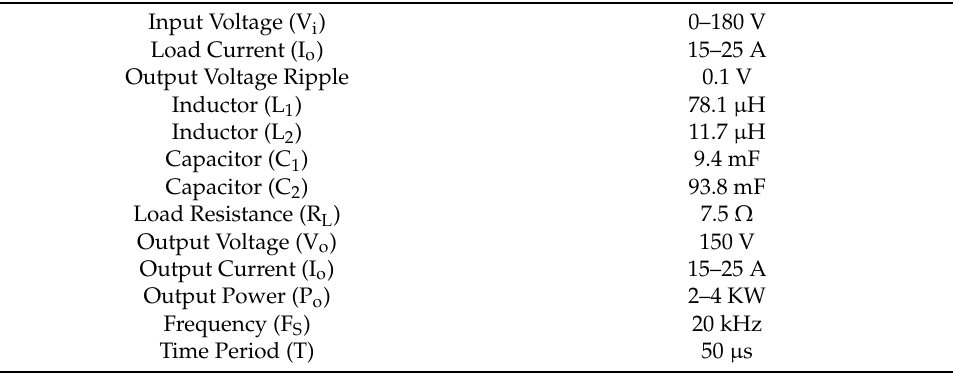
Table 5. Parameters for SEPIC Converter.